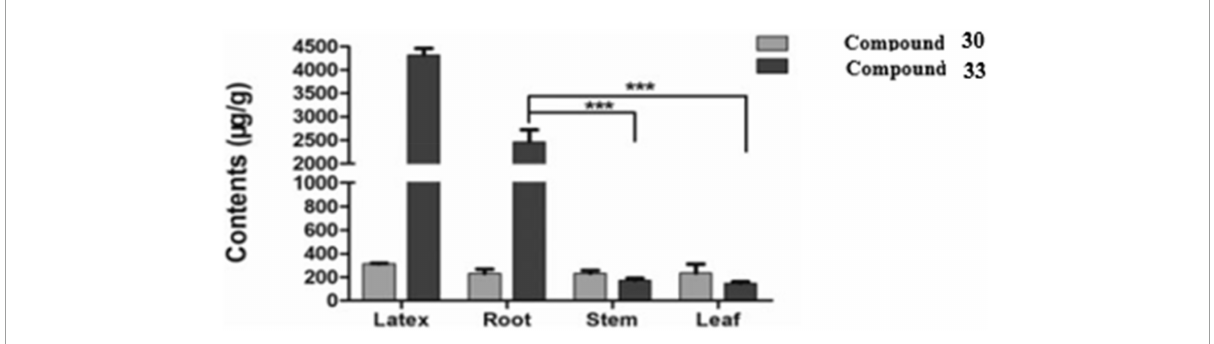
FIGURE7 Content of compounds 30 and 33 in the different parts of E. fischeriana (*** p < 0.001, student’s test) (Deng et al., 2021).